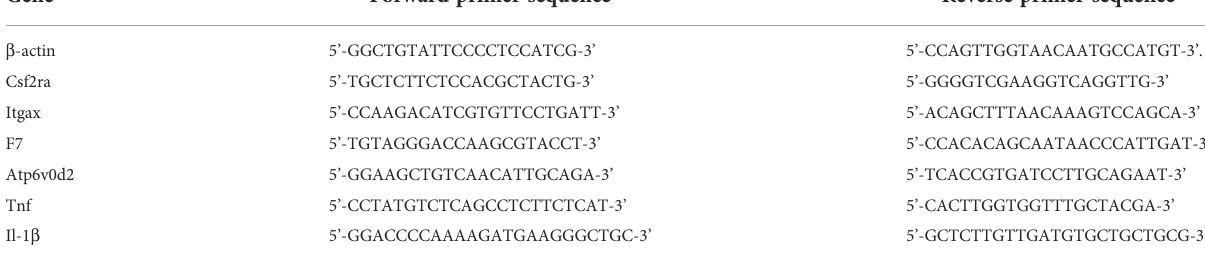
TABLE 1 Primer sequences used for RT-PCR in this